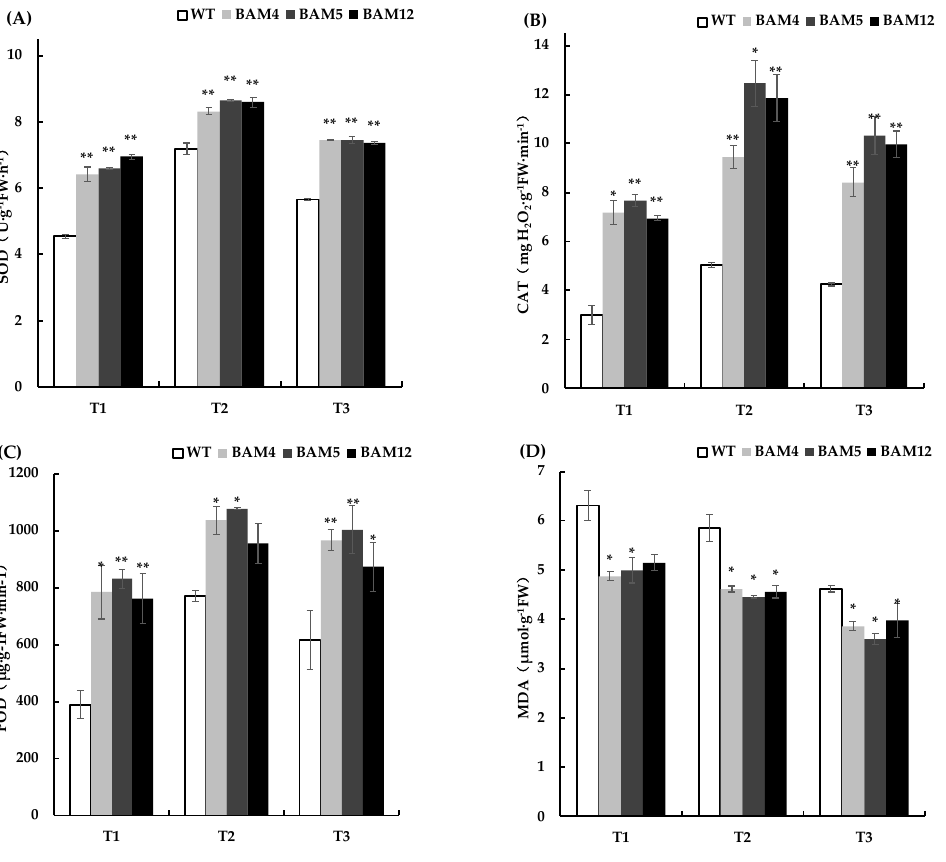
Figure 10. ( A ) SOD activity, ( B ) CAT activity, ( C ) POD activity, and ( D ) MDA content in the transgenic lines and WT plants under different conditions. * and ** indicate a significant difference at p < 0.05 and p < 0.01 compared with WT, respectively.